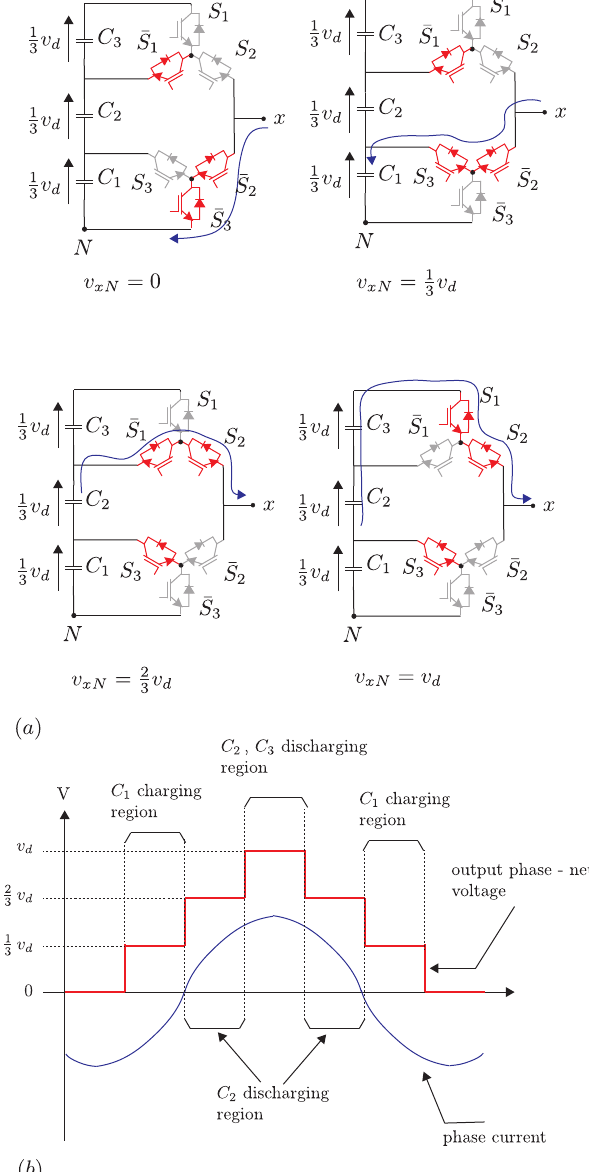
Figure 3. ( a ) Current flow direction, ( b ) dc-capacitors charging and discharging regions in one fundamental